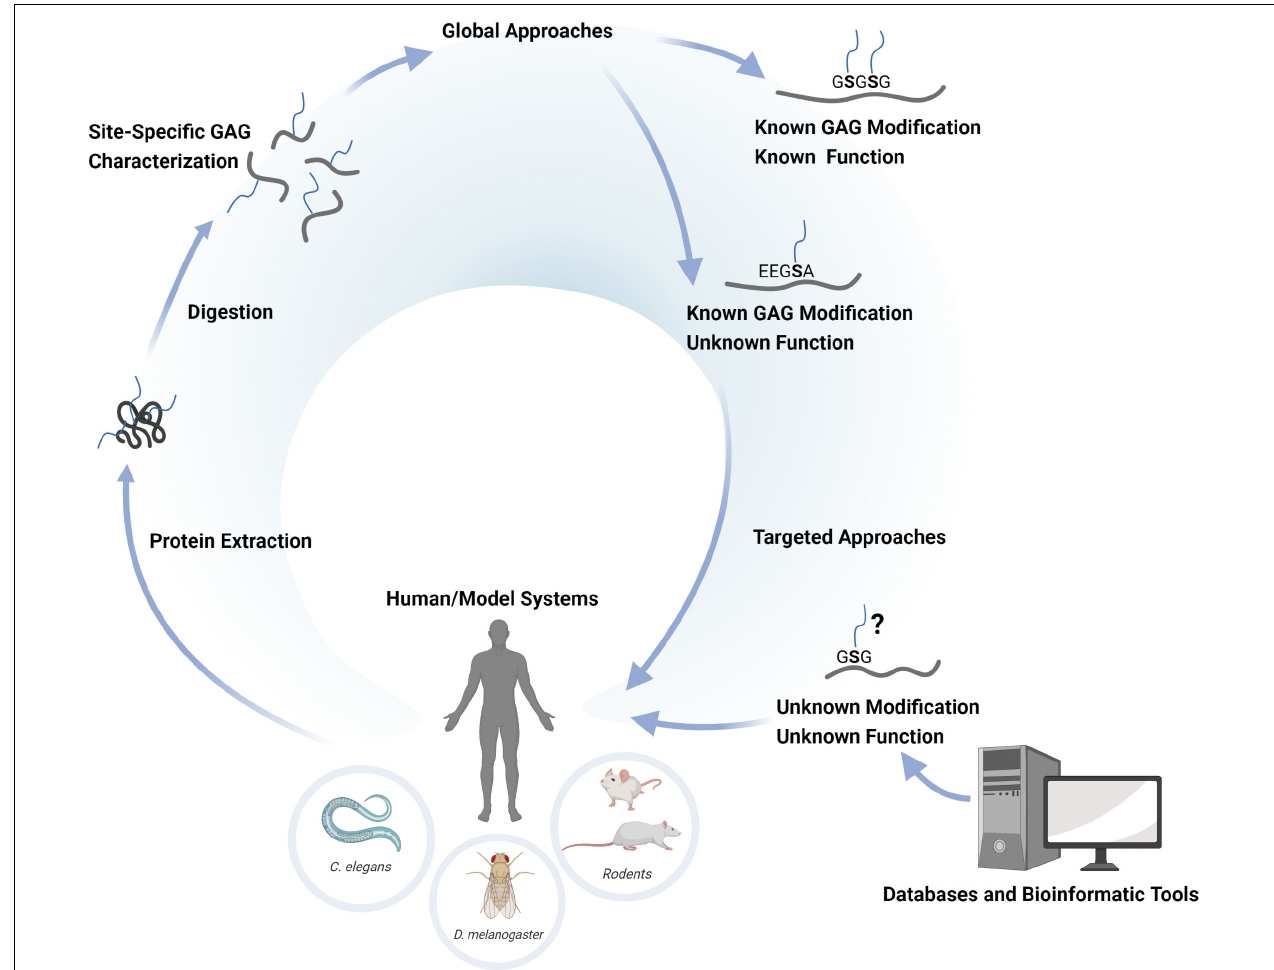
FIGURE 1 | Schematic illustration of the basic concepts concerning glycoproteomic identification of proteoglycans. The identification is achieved by the extraction of proteoglycans from human tissues or from various experimental systems ( C. elegans , D. melanogaster , etc.), followed by the digestion with trypsin and chondroitinase ABC to enrich and generate defined CS-glycopeptides. The glycopeptides are then analyzed by nLC-MS/MS and the data is evaluated through glycopeptide search algorithms. This approach provides a global site-specific characterization of the CSPGs present in the sample system of interest. The identified CSPGs may be previously known CSPGs with known functions, or novel CSPGs for which the functions are yet unknown. The use of targeted approaches (e.g. molecular engineering) may assist in exploring the potential function of novel CSPGs in the sample system of interest. Bioinformatic analysis of the proteome sequences of a given model system may provide information of potential GAG-attachment sites. An assumed GAG-site may thus be verified in vivo using targeted glycoproteomic approaches and functional read-outs.